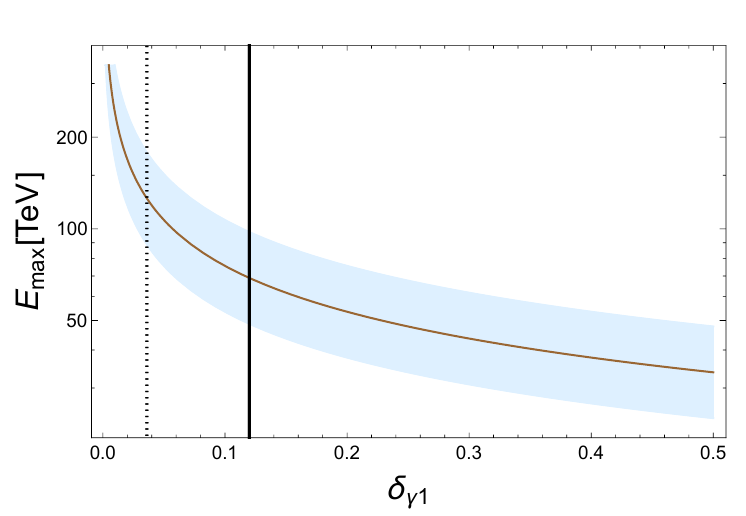
Figure 3 . The unitarity-violating bound as a function of δ γ 1 . The model-independent bound is obtained from eq. (3.4). The band around the model-independent bound results from varying the unitarity bound to 1 ≤ ˆ M ≤ 2 . The solid black line represents the 95% C.L. limits on δ γ 1 obtained 2 from ATLAS [25], whereas the dotted one represents the 95% C.L. HL-LHC projections obtained from